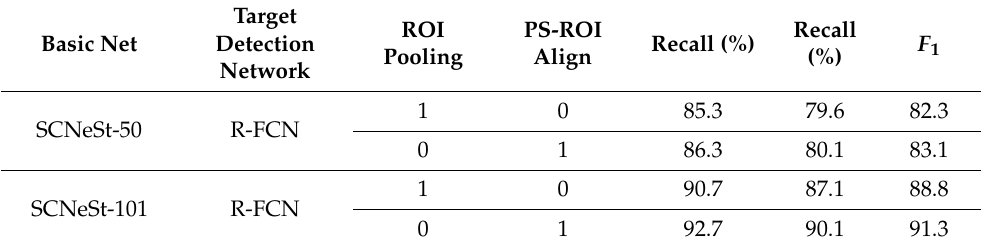
Table 3. Added ROI network parameter comparison.